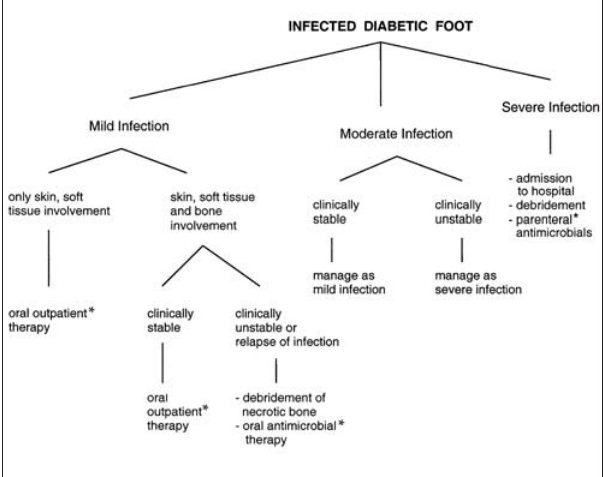
Figure 1) Algorithm for the selection of antimicrobial therapy. *See Table 1 for antimicrobial choices